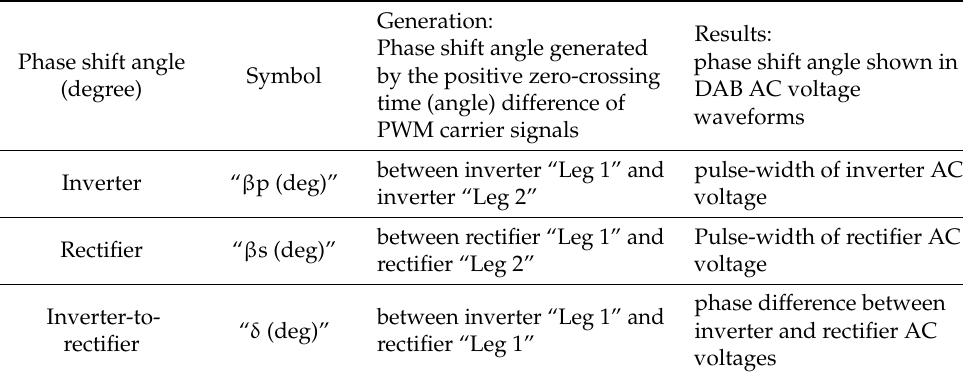
Table 2. DAB Phase Shift Angle Generation and